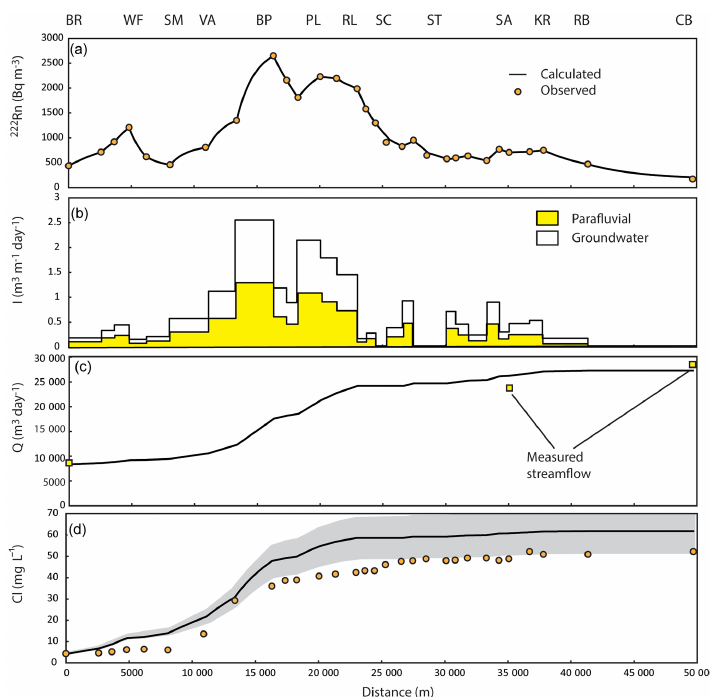
Figure 6. (a) Calculated and observed 222 Rn activities for February 2015 resulting from assigning 50% of the calculated inflows as paraflu- vial flow. (b) Variation in groundwater and parafluvial inflows. (c) Calculated streamflow resulting from the groundwater inflows (Eq. 2) vs. measured streamflow at Stratford and Chinns Bridge. (d) Predicted vs. observed Cl concentrations. Shaded field is the range resulting from varying groundwater Cl concentrations within the 95% confidence